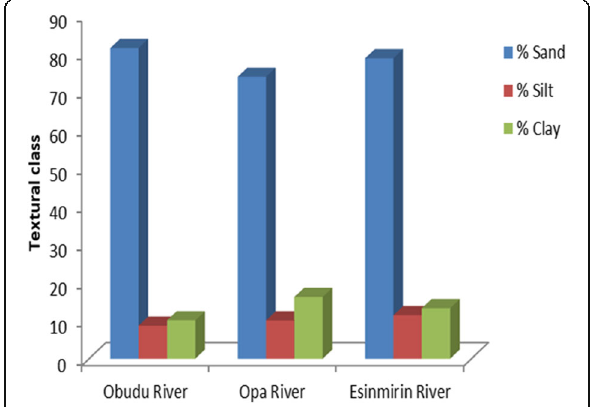
Fig. 2 Textural composition of sediments in Obudu, Opa, and